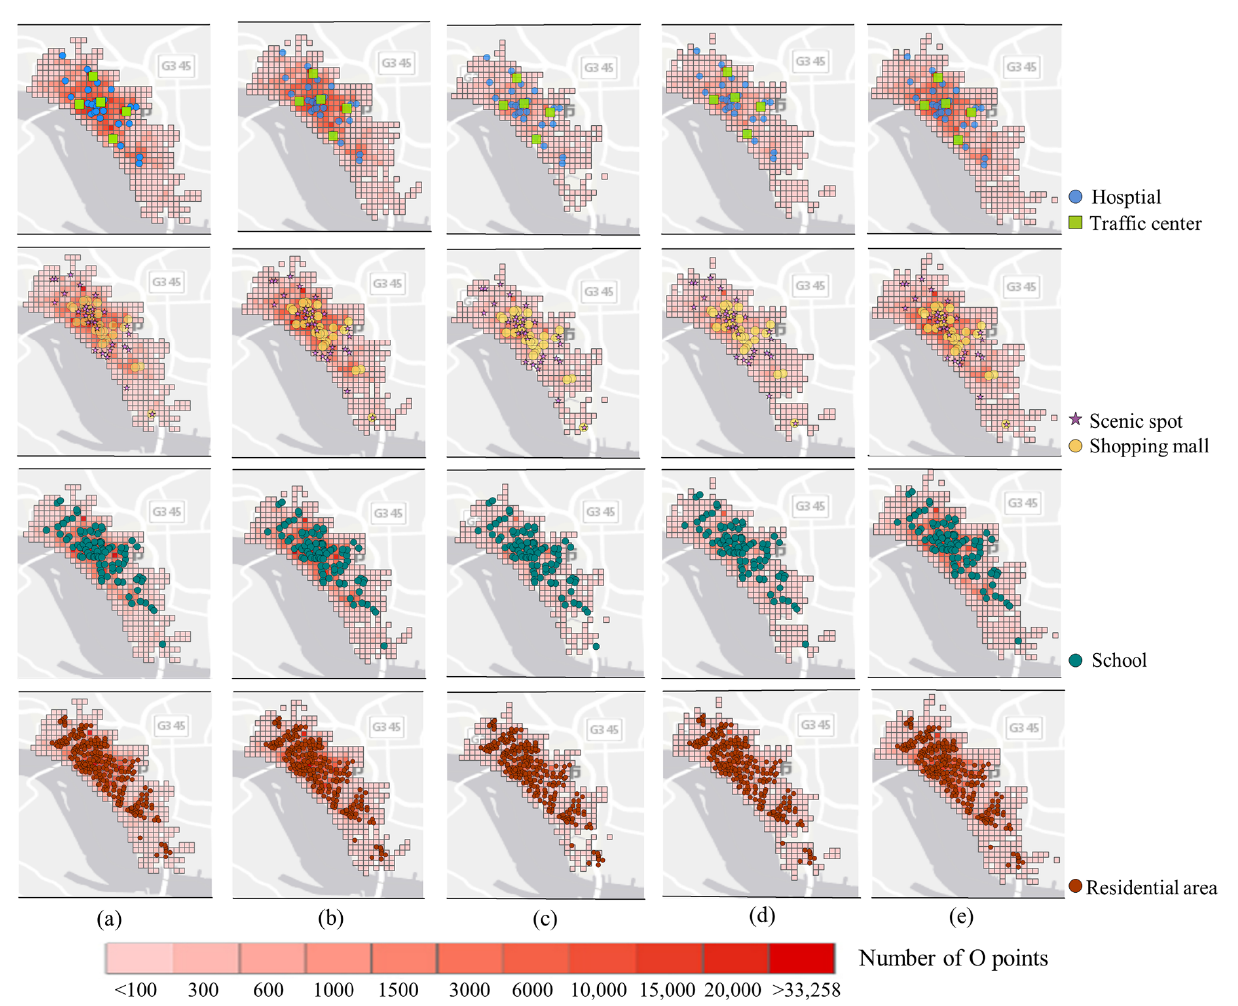
Figure 8. The density of O points around each UFA in ( a ) normal period of society, ( b ) early period of COVID-19, ( c ) outbreak period of COVID-19, ( d ) rework period of society, and ( e ) recovery period of society. O point represents the origin point in one trajectory of residential travel. Marked points were obtained from the center points of UFAs. The size of the grid is 1 km × 1 km.